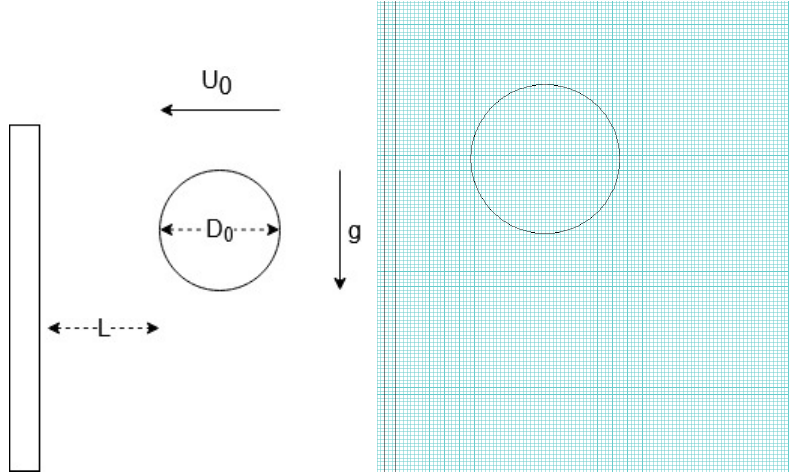
Figure 1. Schematic ( left ) and computational domain ( right ) of the problem